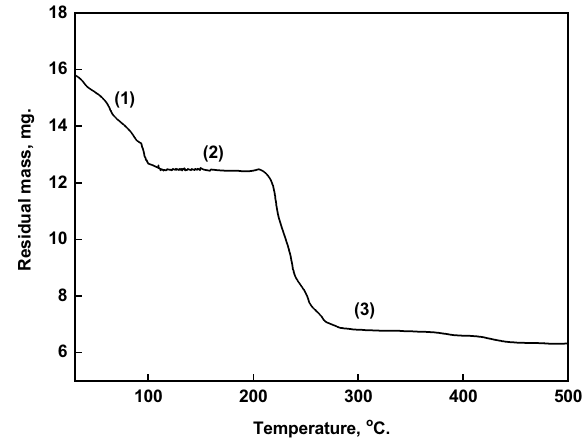
Figure 2. Thermogravimetric analysis in air atmosphere of Cu-Asp MOF.